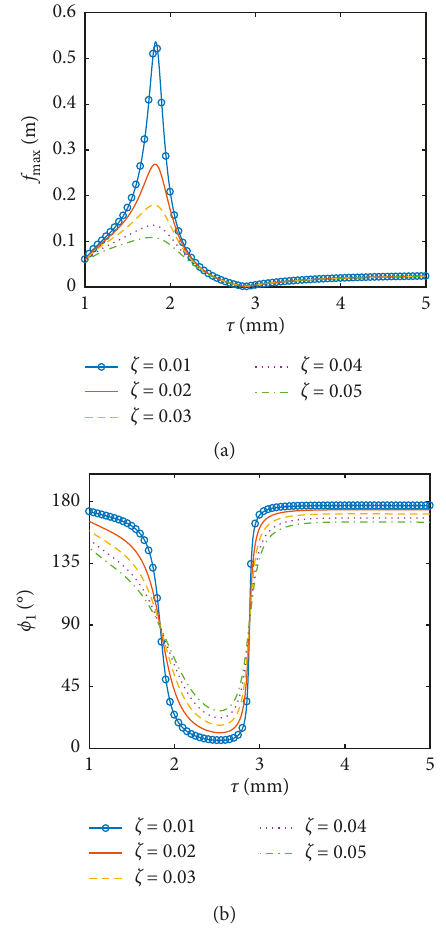
Figure 16: The amplitudes and the phases of the surface wave height versus the thickness of the flexible baffle for R z � 0 . 7m. (a) the amplitude of the surface wave height, (b) the 1 phase of the surface wave